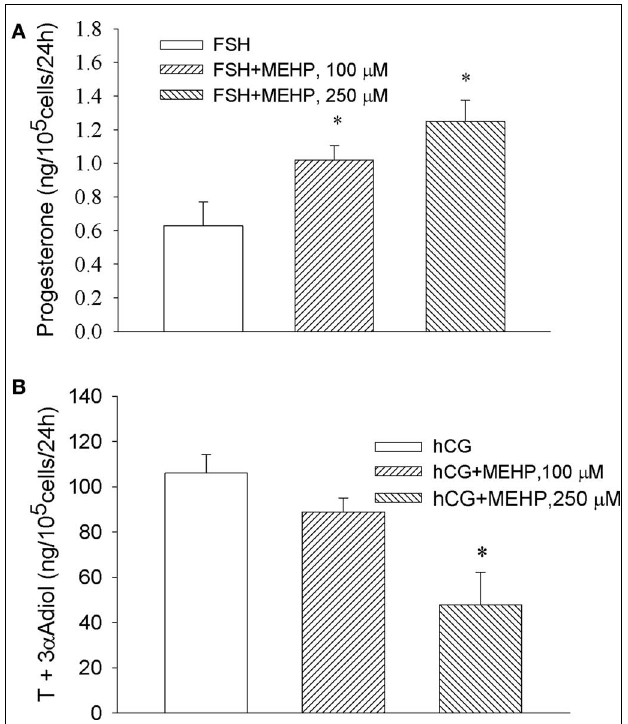
FIGURE 2 | Opposite effect of MEHP on FSH and hCG-stimulated steroidogenesis in immature granulosa cells (A) and Leydig cell progenitors (B). The steroidogenic cells were cultured without or with MEHP at different concentrations for 24h and then incubated with hCG (10ng/ml) and FSH (50mU/ml) in the absence or presence of the same concentrations of MEHP for additional 24h.Testosterone (T) and 3 α -Adiol and progesterone in the culture medium were then measured by RIA.The mean values ± SEM for four independent steroidogenic cell preparations are presented. * p < 0.05 compared to treatment with FSH and hCG.